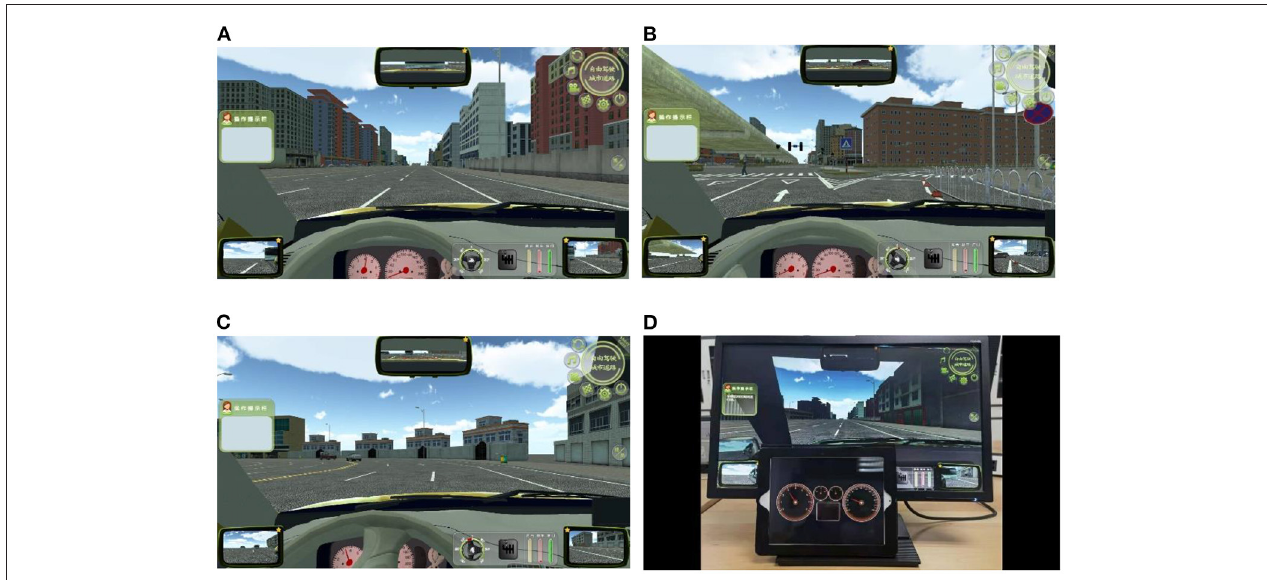
FIGURE 4 | Part of the scenes on the driving simulator screen: (A) straight line, (B) crosswalk, (C) left turning, and (D) a photograph of field